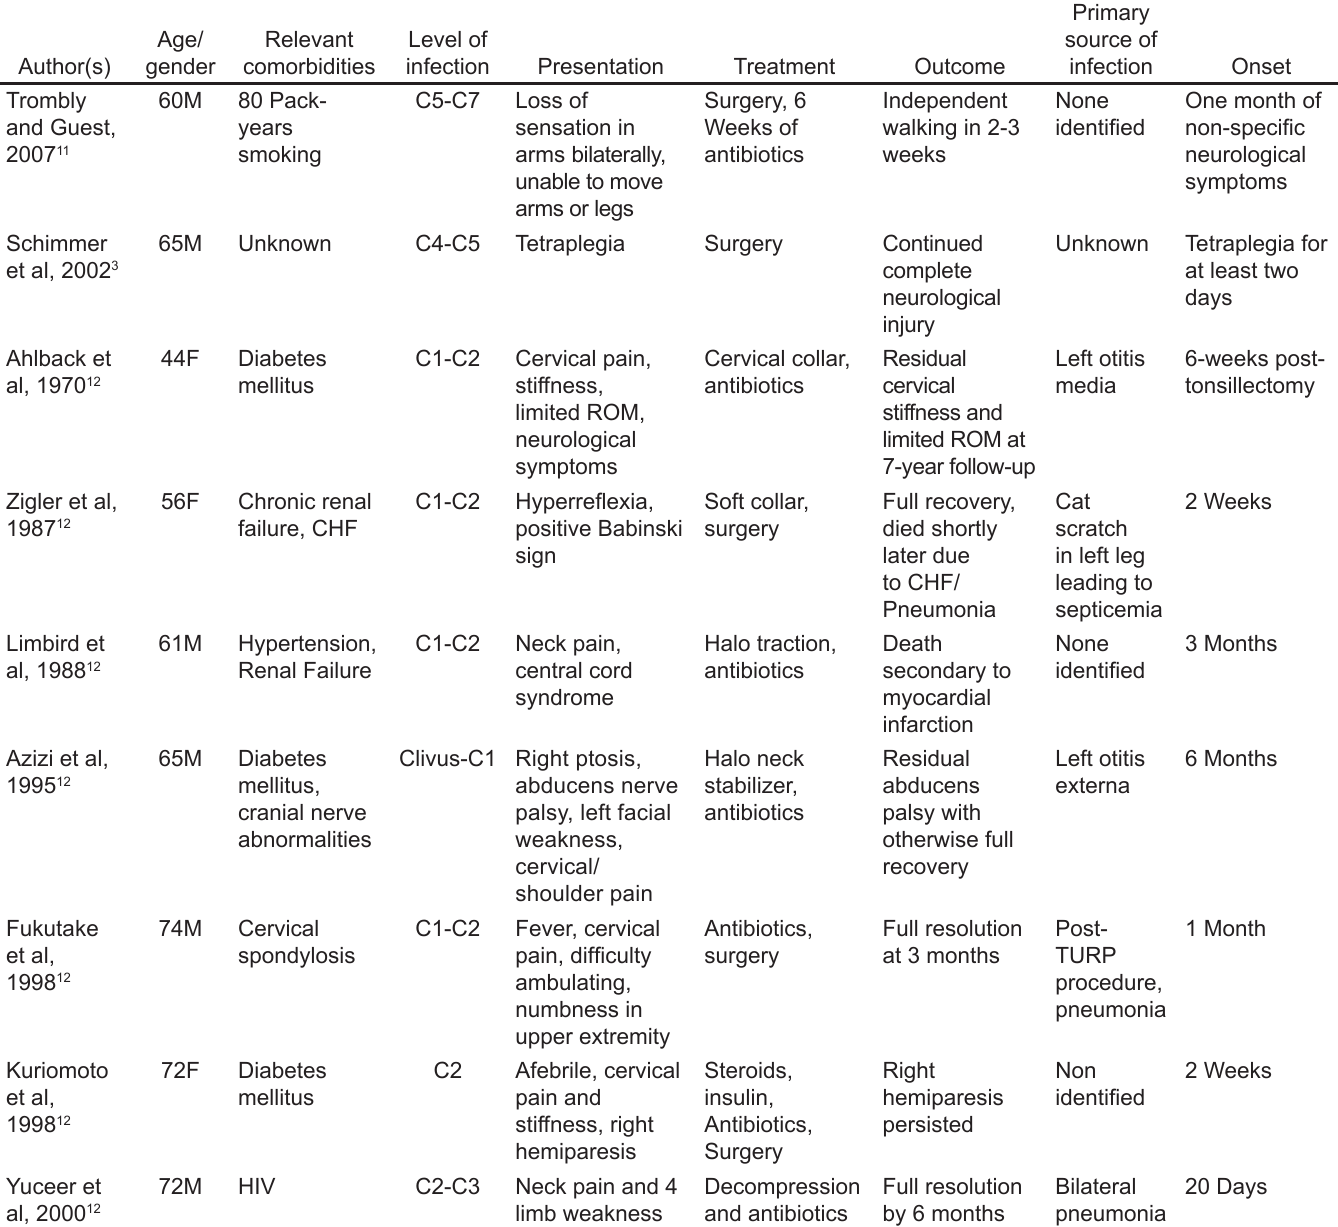
Table. Summary of previous published case reports involving cervical spine abscess with sub-acute neurological symptoms, detailing age and gender, relevant comorbidities, level of infection, presentation, outcome, and duration of original